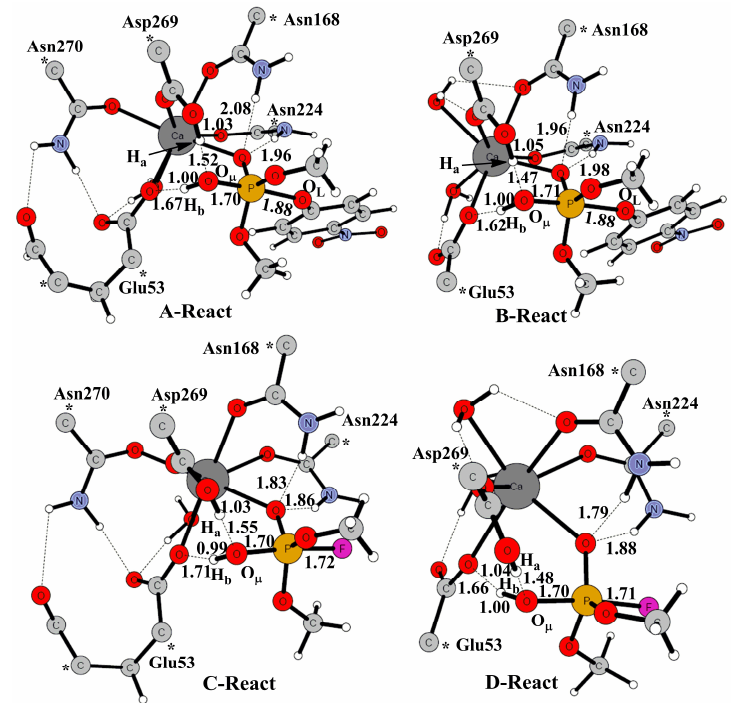
Figure 3. Optimized geometries of reactants along the reaction paths of ( A ) PON1W-Paraoxon, ( B ) PON1M-Paraoxon, ( C ) PON1W-DFP, and ( D ) PON1M-DFP models. The frozen atoms are marked with asterisks.